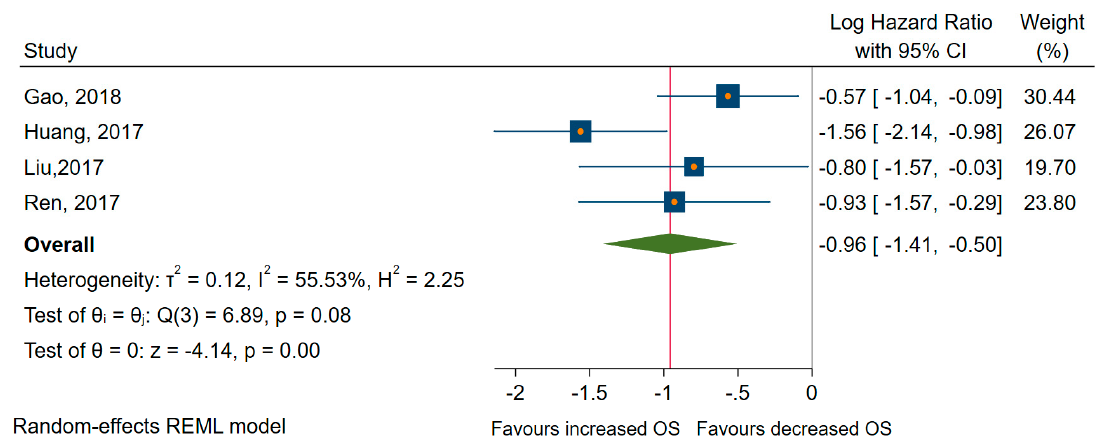
Figure 7. Forest plot of the association between downregulated microRNAs (miRNAs) and OS.